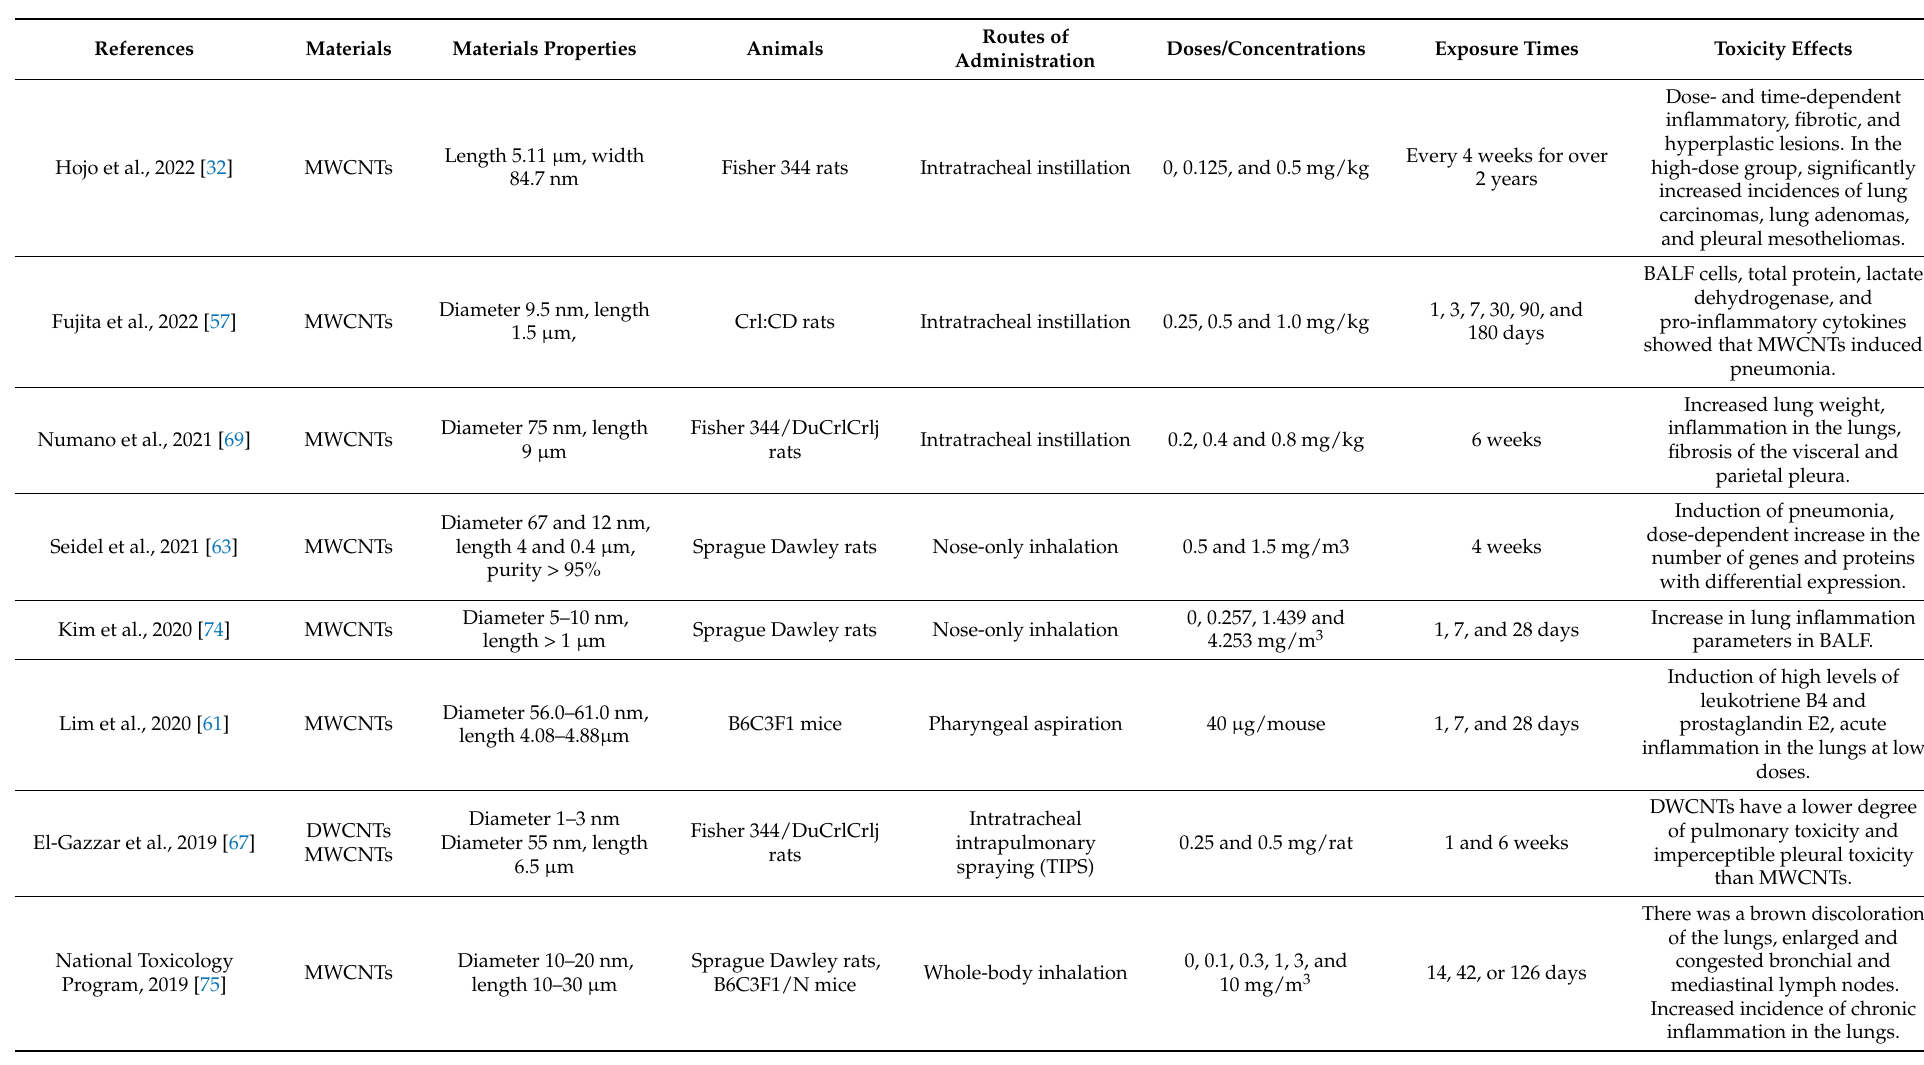
Table 1. Pulmotoxicity of pristine carbon nanotubes using rodents as animal